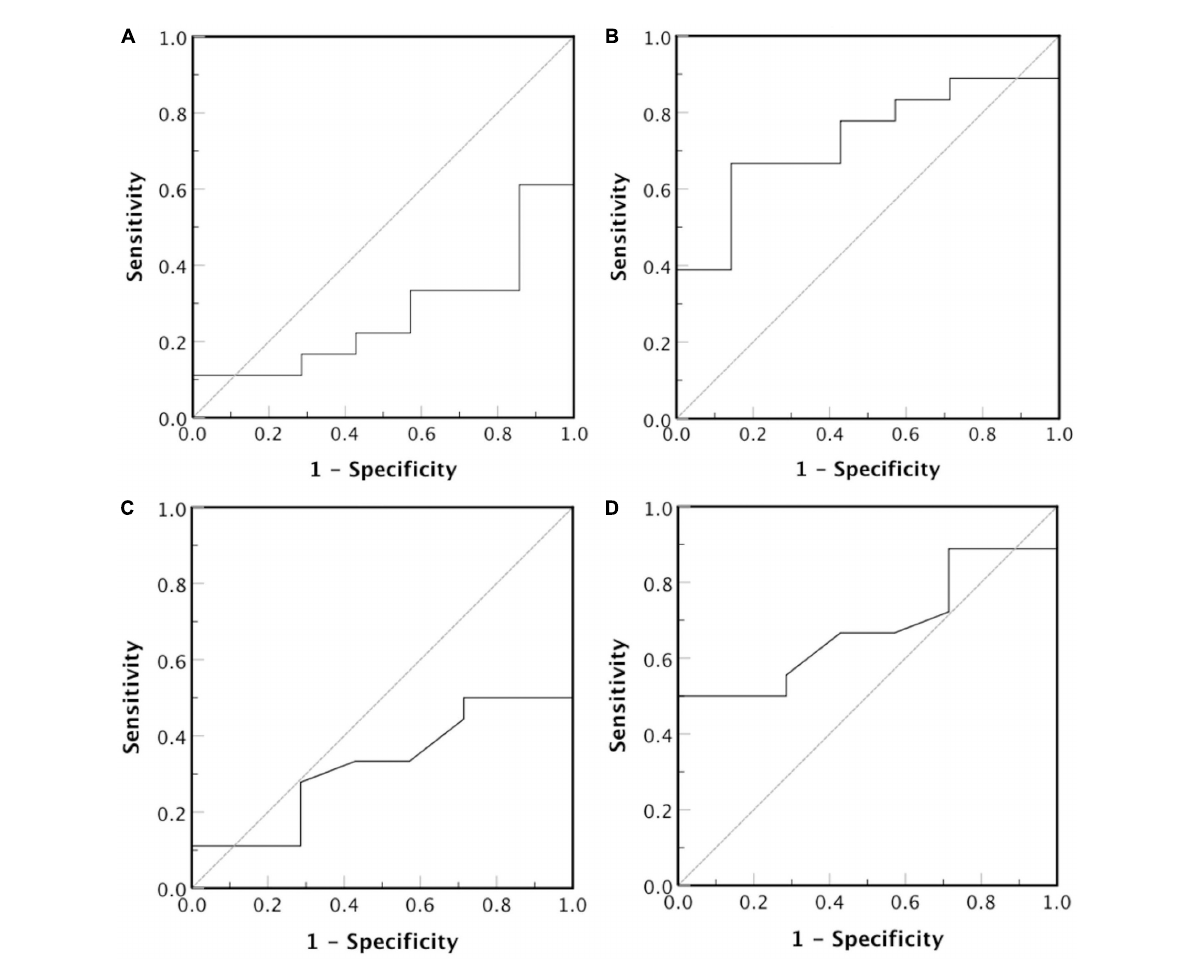
FIGURE8 Receiver operator characteristic curve for LDL-P diameter (nm) and serum concentration (nmoles/L). The test hypothesis is if (A) smaller or (B) larger LDL-P particles, and (C) smaller or (D) larger concentration of LDL-P particles correlate with high risk for CVDs